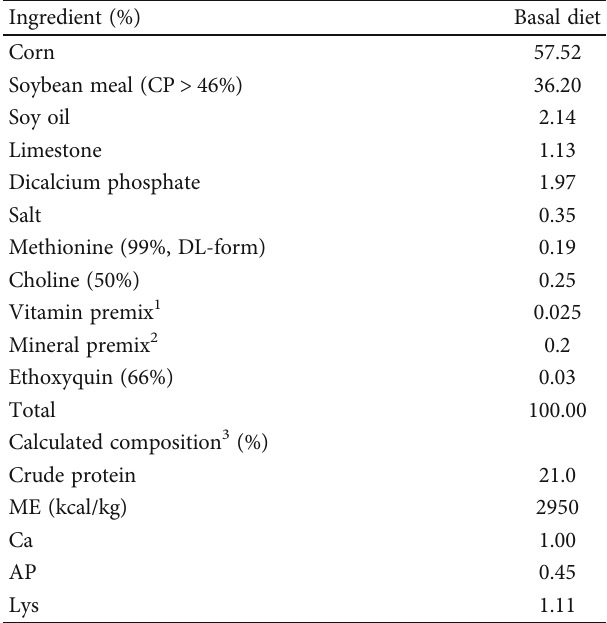
Table 1: Basal diet composition (as-fed